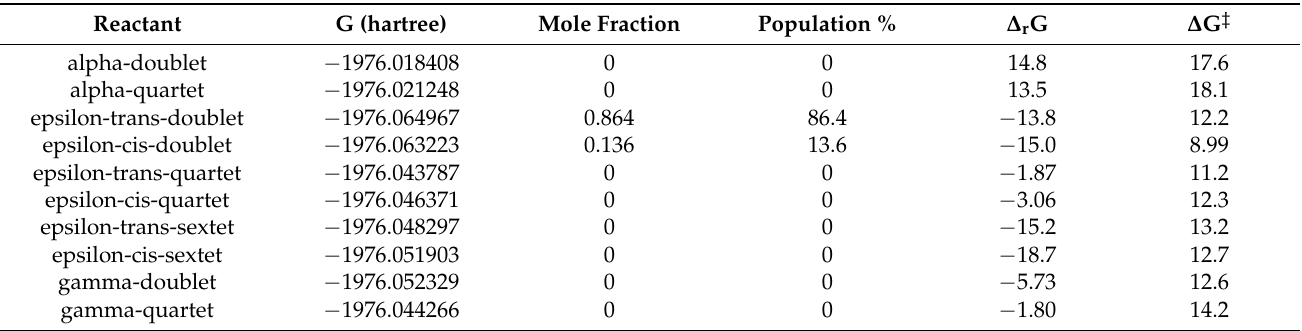
Table 9. Boltzmann distribution for radical conformers present in reaction coordinate III for the α